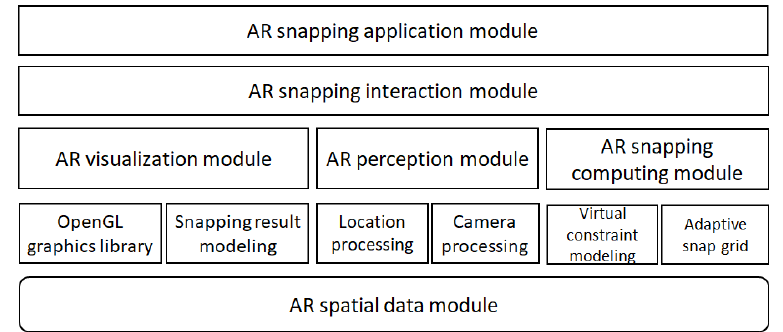
Figure 1. Snapping algorithm (ARSnap) system architecture.